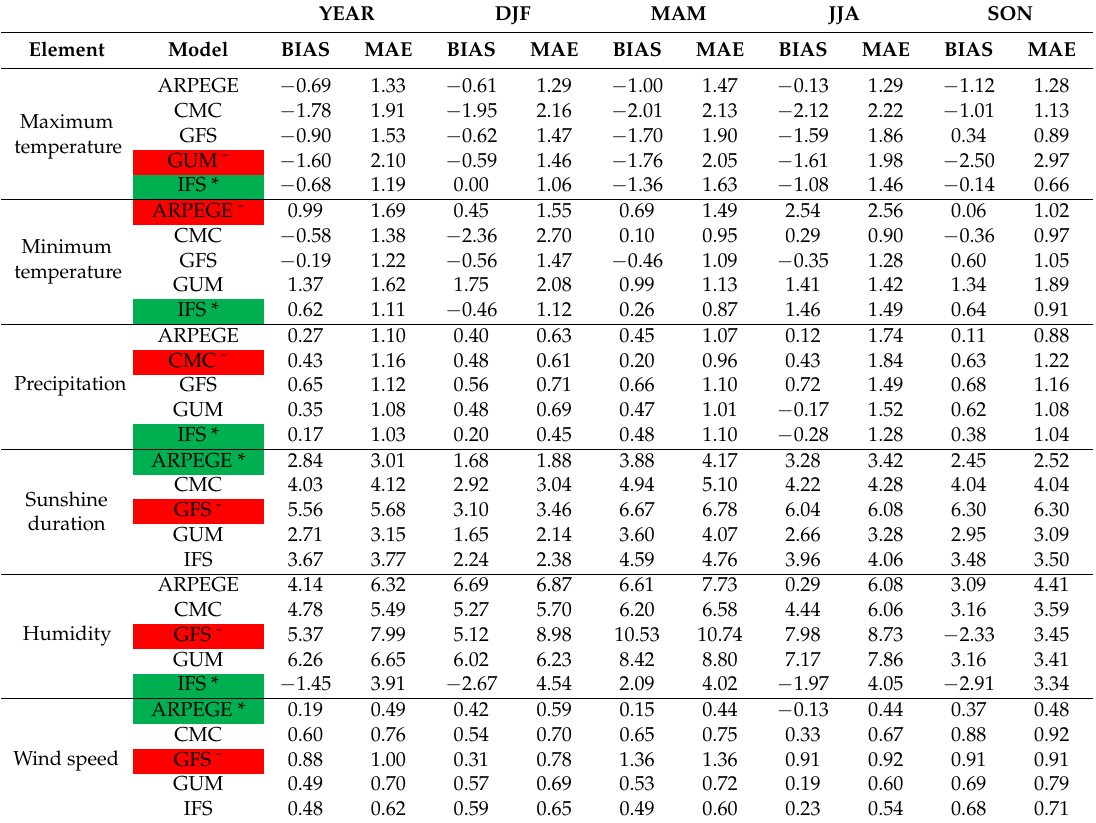
Table 2. Validation characteristics (bias and MAE—mean absolute error) of 5 NWP (numerical weather prediction) models for individual seasons (green and asterisk = the best model, red and dash = the worst, estimated based on MAE for annual values) for 3 days